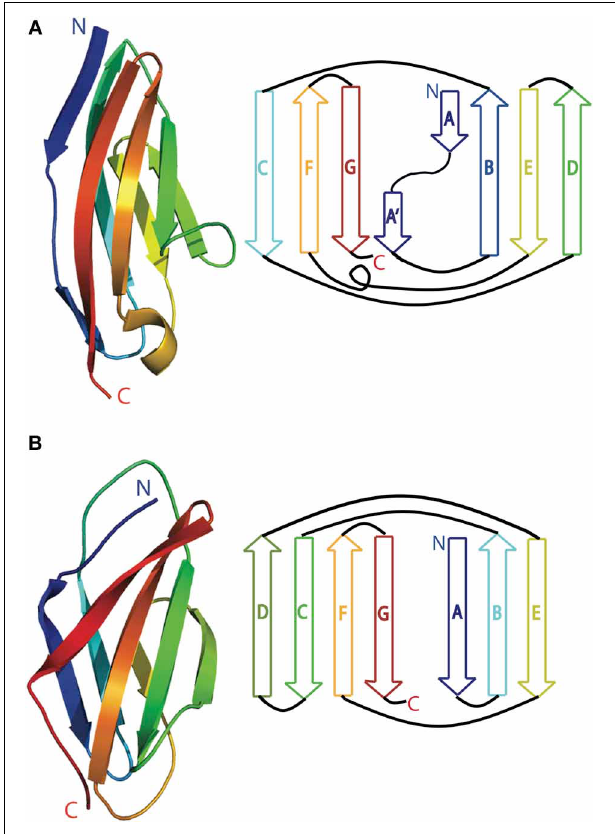
FIGURE 1 | Cartoon (left) and schematic (right) of a typical (A) Immunoglobulin-like domain (M7 of titin; pdb 3PUC) and (B) fibronectin type III domain (titin domain A77; pdb 3LPW). Blue is the N-terminus and red is the C-terminus.